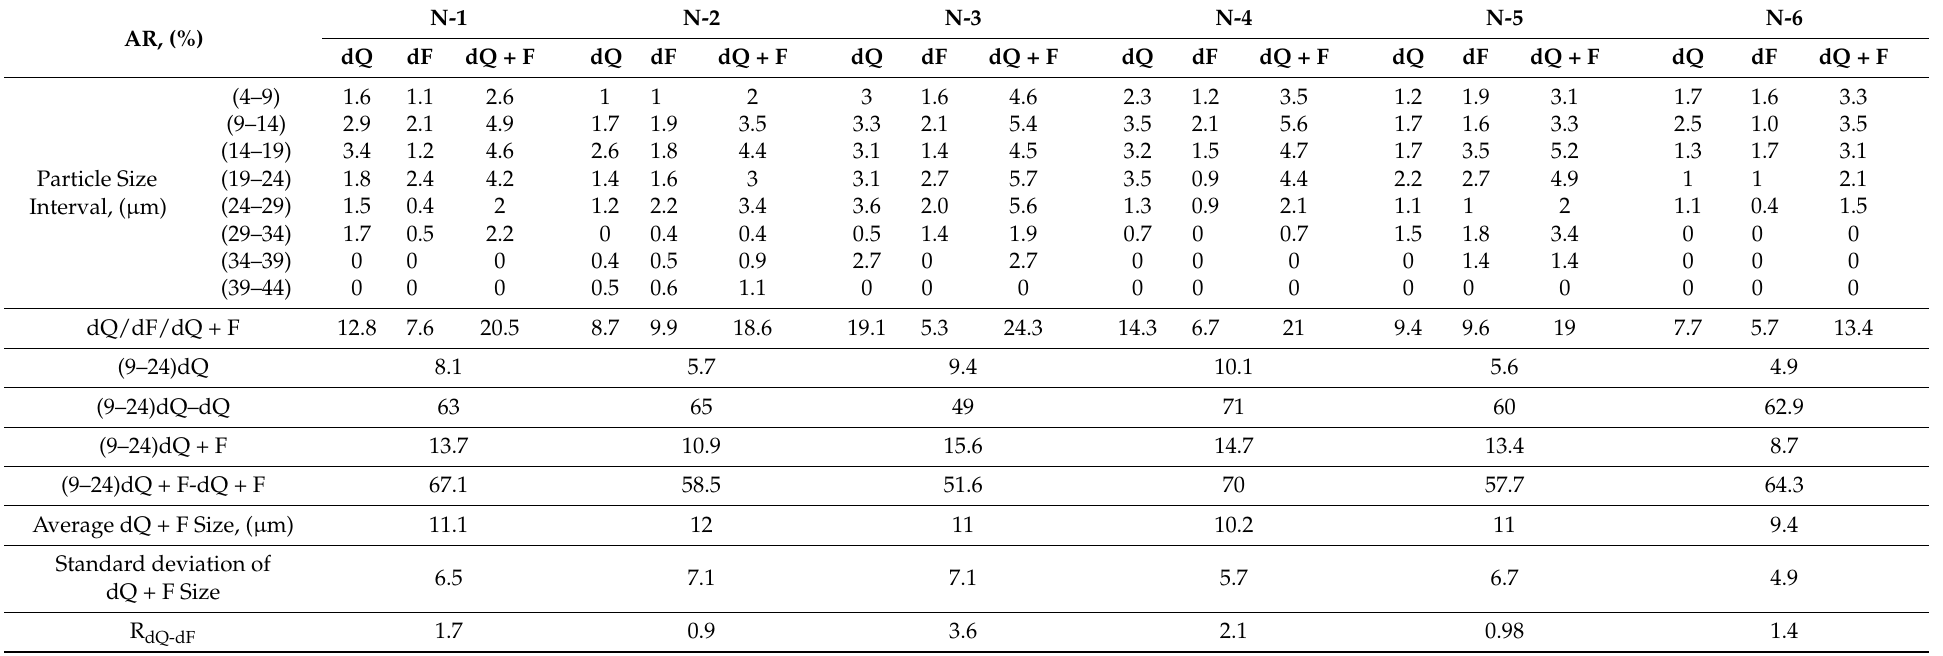
Table 2. Image processing results of detrital quartz and